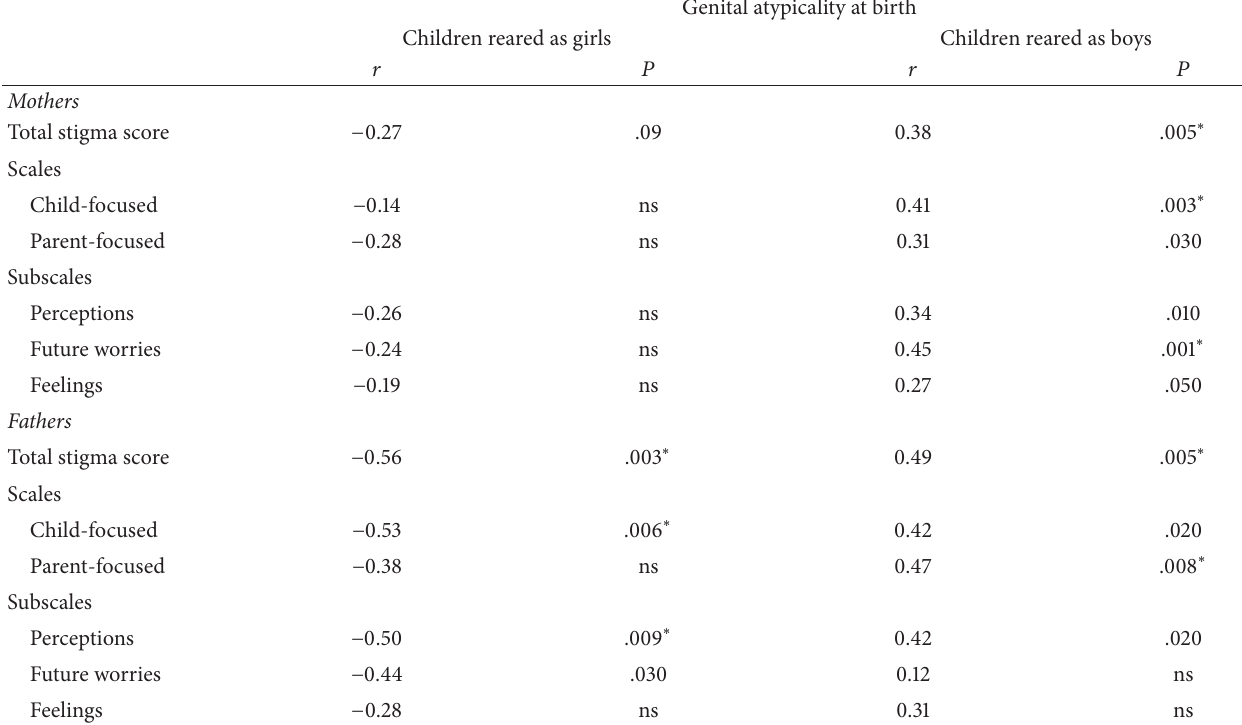
Table 6: Correlation of reported stigma by mothers and fathers with child’s genital atypicality at birth. Genital atypicality at